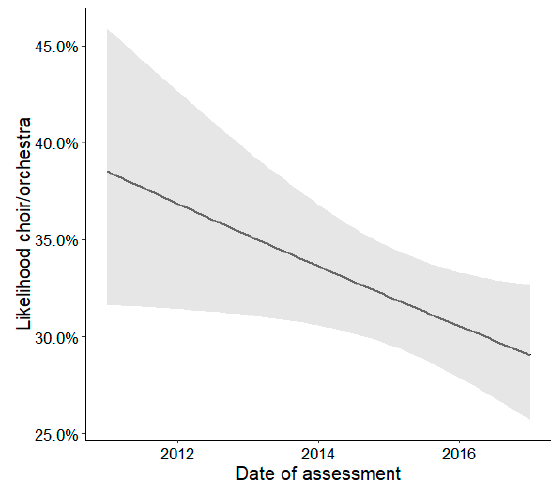
Figure 2. Effects plot illustrating the estimated changes over time (2011–2017) described as association between choir/orchestra and date of assessment. The shaded area indicates the 95% confidence intervals of the estimated effect.